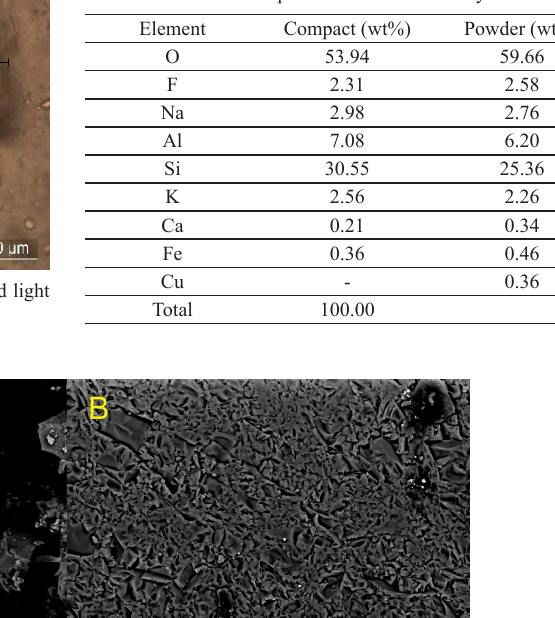
Table 1. Elemental composition of Macusanite by